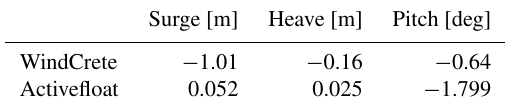
Table 9. Floater’s static